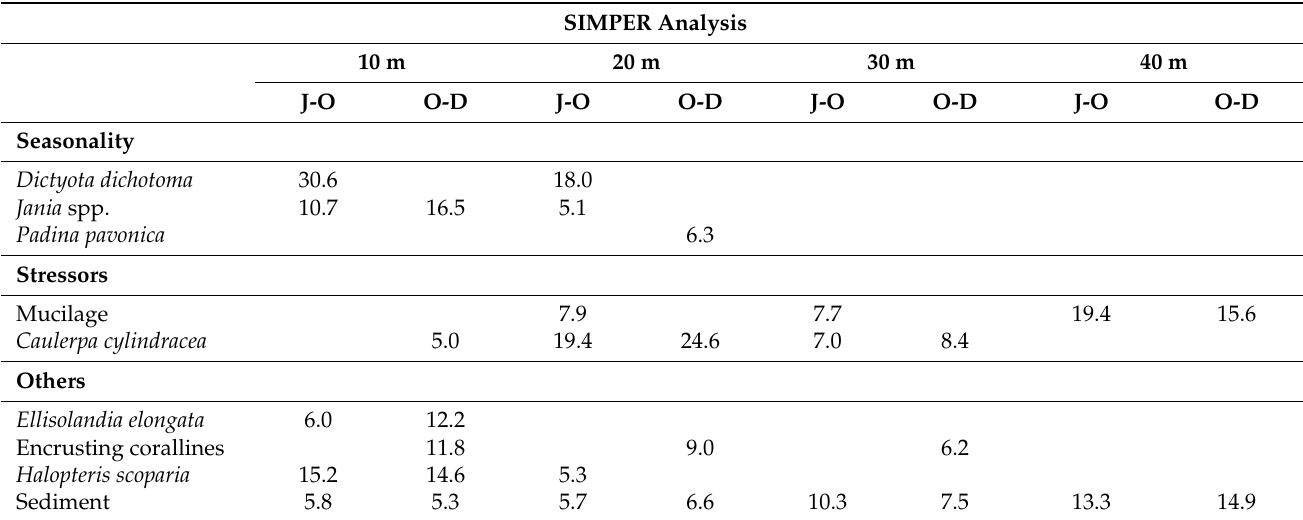
Table 3. Descriptors that mostly contributed (>5%) to the similarity between June–October and between October–December identified by SIMPER analysis (based on the Bray–Curtis index). J-O: